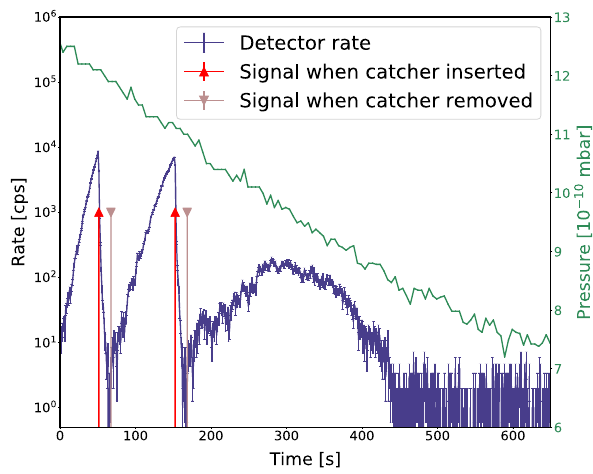
Fig. 12 Backgroundmeasurementwithdecreasingpressure(bypump- ing out previously injected argon gas) when the electron catcher was run in safeguard mode (setting D, Table 1). The electron catcher suc- cessfully quenches discharges until the discharges disappear below ∼ 8 × 10 − 10 mbar. Pressure values are corrected for argon